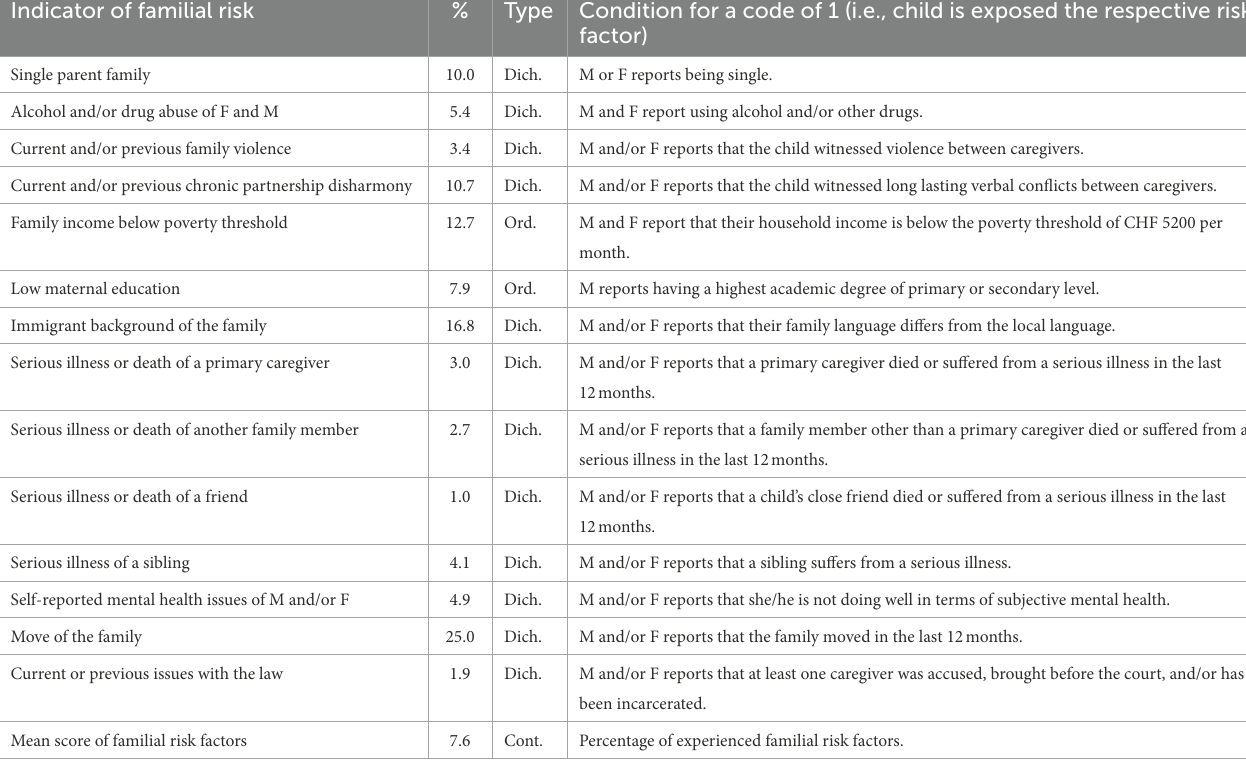
TABLE 1 Operationalization of all indicators of familial risk factors. Indicator of familial